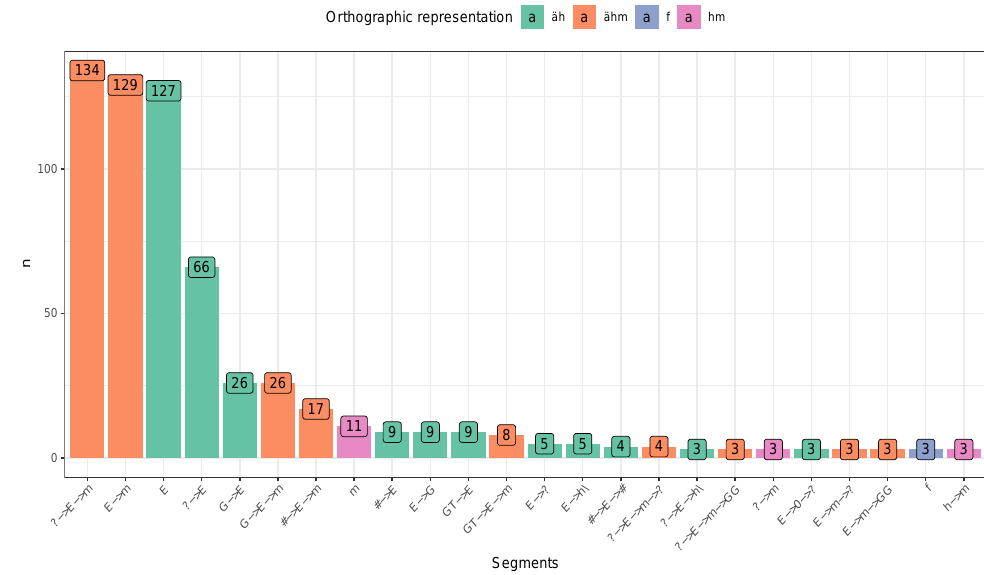
Figure 13. Segments with n > 2 instances of the vocalic ( fv ) form per sequence and orthographic